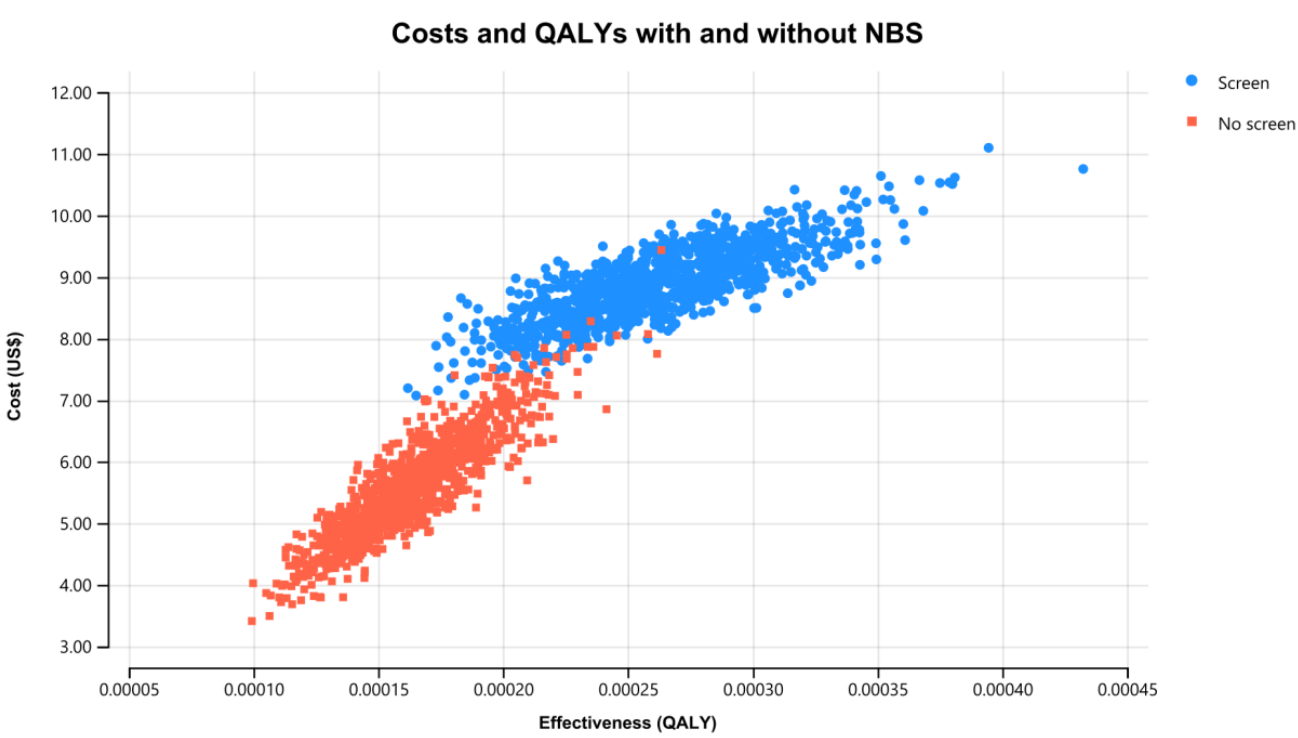
Figure 2. Costs and QALYs for SCID NBS and no SCID NBS, government perspective, 60 years, discounted US$ (d = 3% p.a.).